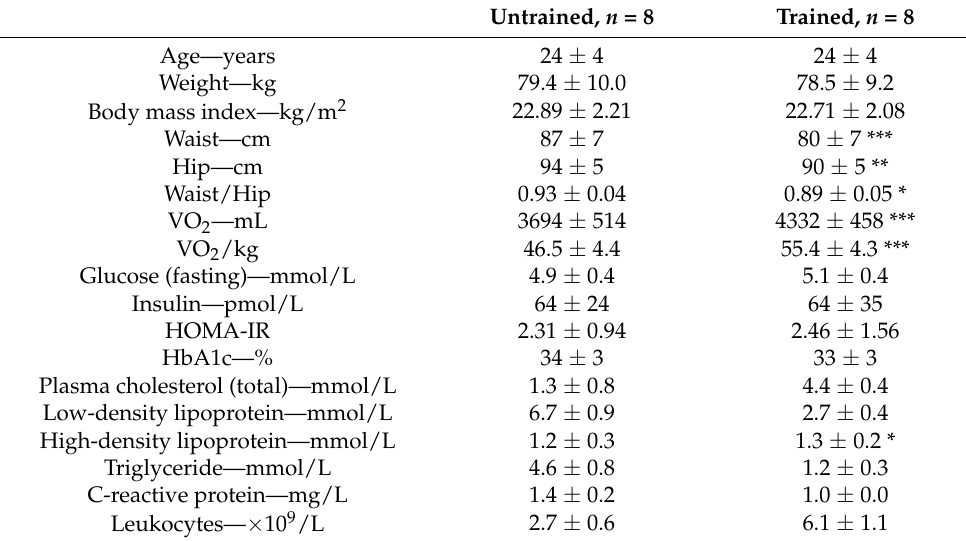
Table 1. Clinical characteristics of study